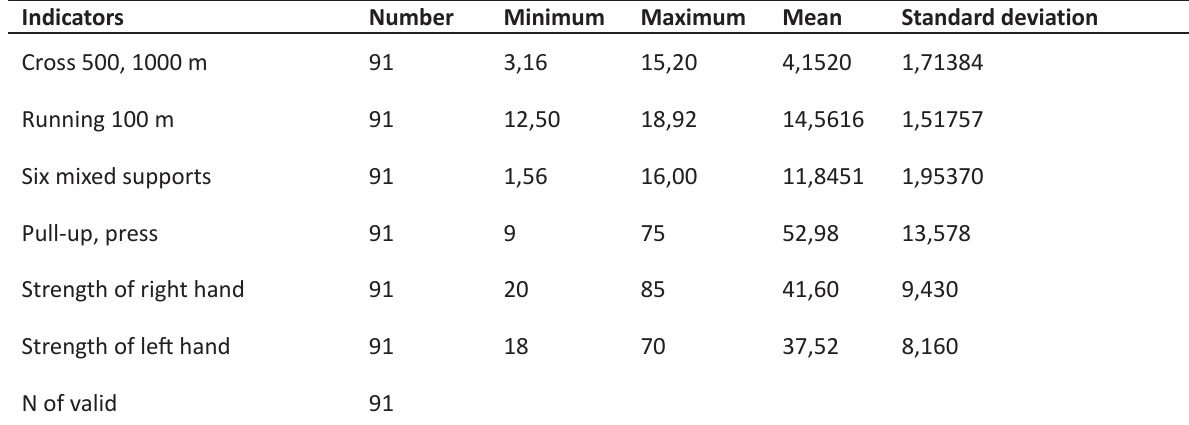
Table 3. Statistics of the second group of indicators